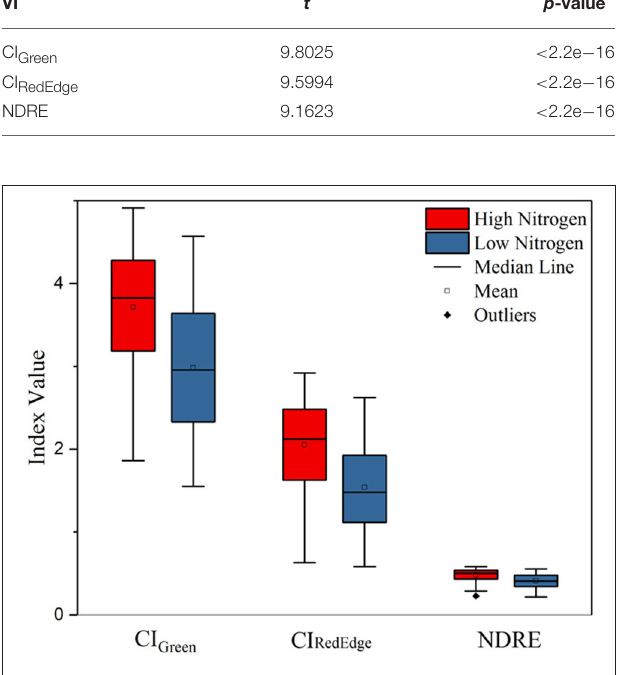
FIGURE 6 | Boxplot of three VIs (CI Green , CI RedEdge , and NDRE) derived from the late season multispectral images of the low and high nitrogen treatments.